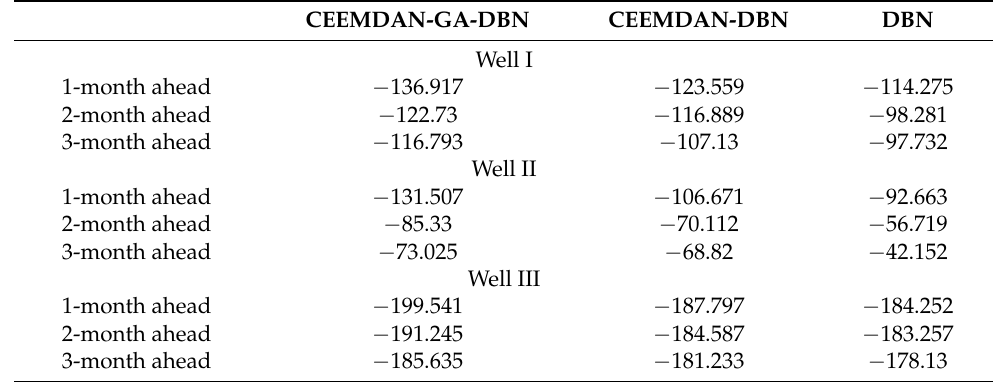
Table 6. AIC values of the CEEMDAN-GA-DBN, CEEMDAN- DBN and DBN models for the 1-, 2- and 3-month ahead GWL forecasts at Well I, Well II, Well III.